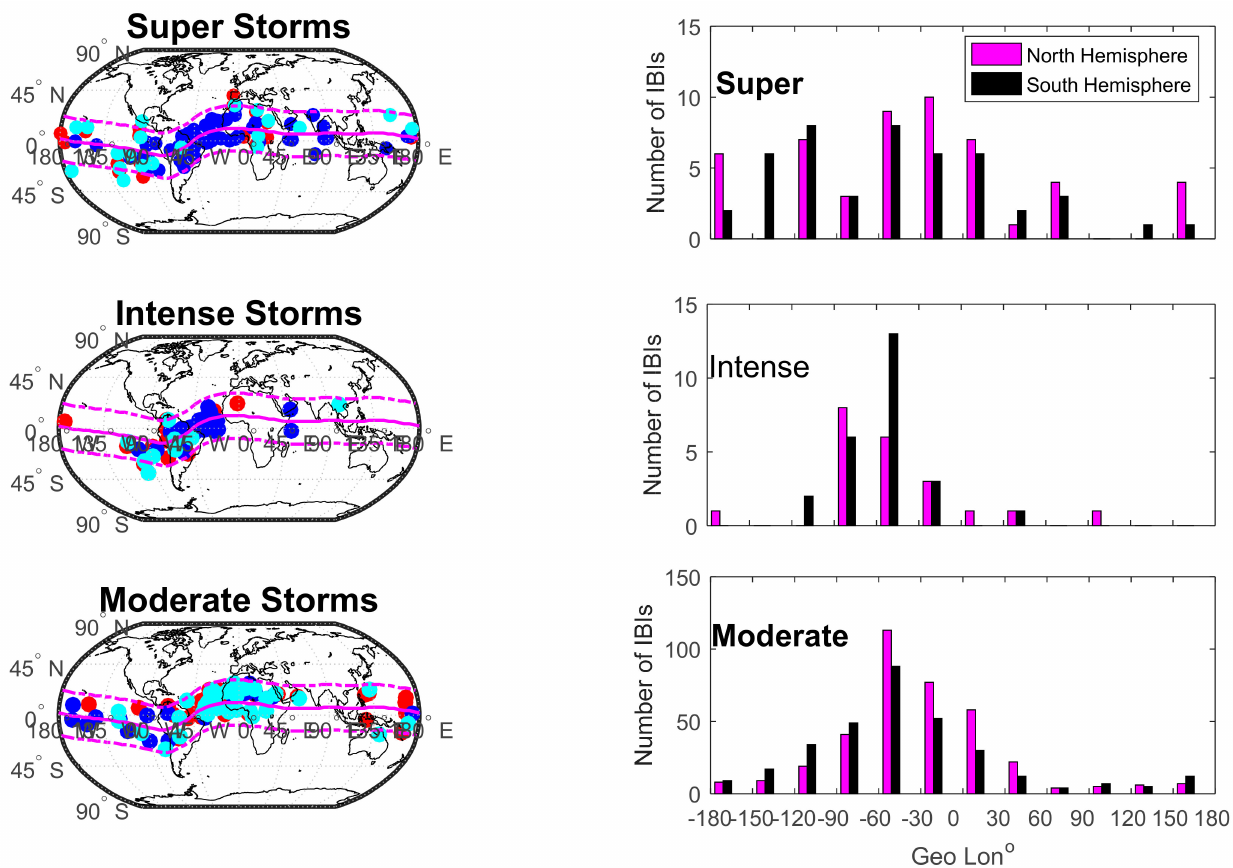
Figure 2. Global distributions of IBI events during super, intense, and moderate storms from top to bottom observed by Swarm A, B, and C in red, blue, and cyan dots, respectively, on the left. The dashed line corresponds to the ± 20 ◦ latitude from the dip equator. The right column is its corresponding IBI occurrence number in the northern and southern hemispheres in magenta and black bars,